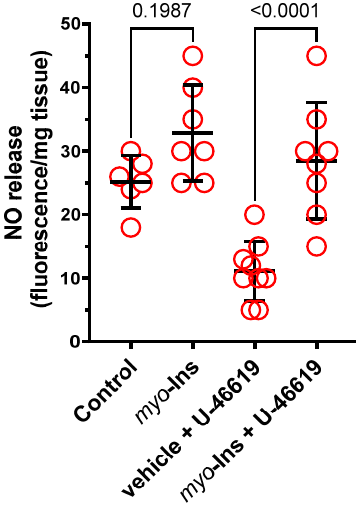
Figure 4. The effect of pre-incubation with myo -inositol (1.0 μ M) on the basal release of NO in control arteries and arteries subjected to U-46619. Results (means ± SD) are expressed as arbitrary units of fluorescence (AU) per milligram of tissue. Number of animals: n = 6–8.